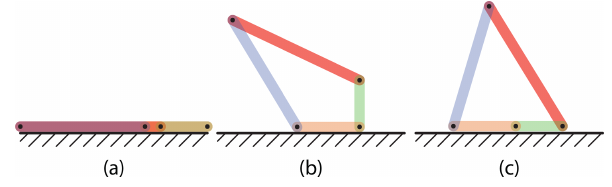
Figure 1. Theoretical diagram of ThUDS in (a) flat, (b) deploying, and (c) blocked deployed